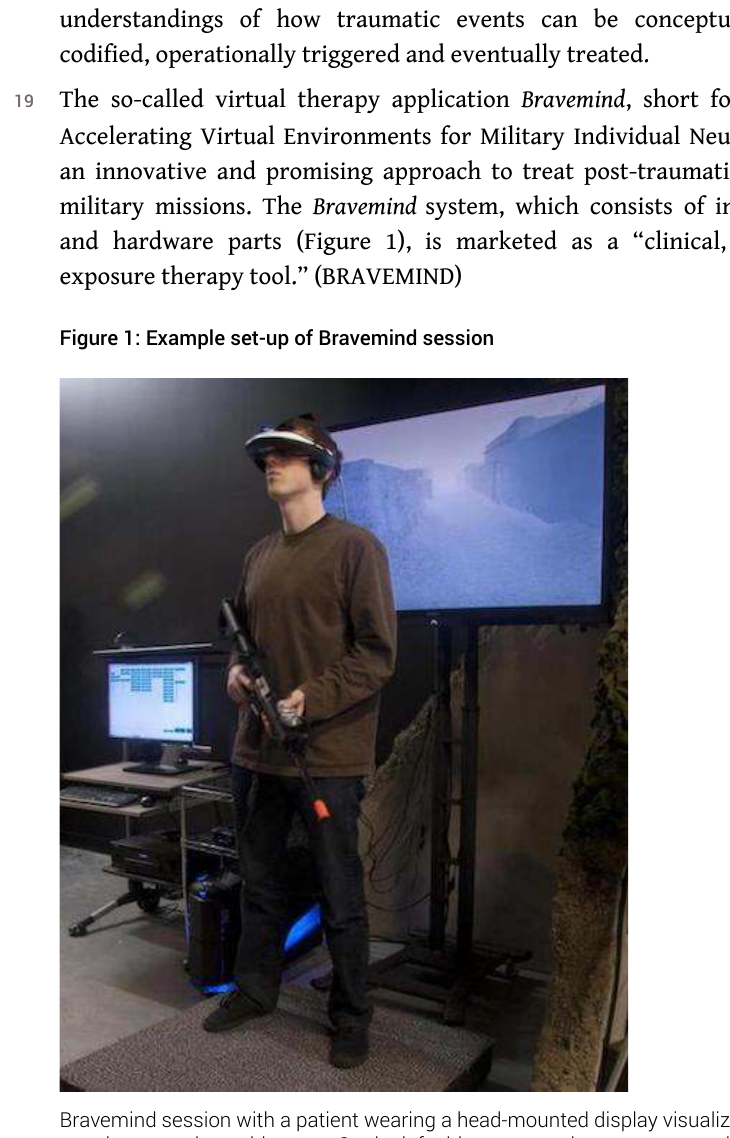
Bravemind session with a patient wearing a head-mounted display visualizing a virtual scenario and carrying a mock machine gun. On the left side one sees the computer station used by the therapist to monitor the